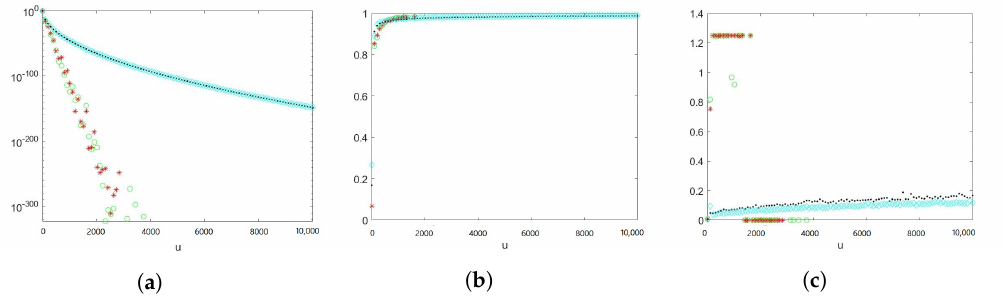
Figure 1. The random variable N is geometrically distributed with success probability p = 0.2, W i i.i.d ∼ Exp ( 1 ) , X i i.i.d ∼ Erlang ( 1,3 ) , where i = 1, . . . , N . Green circles: ConAK1. Red stars: ConAK1+CV. Black dots: ConAK1+IS (conditioning and IS on exponential). Cyan diamonds: ConAK1+IS+CV (conditioning and IS on exponential). ( a ) Estimates of (cid:96) ( u ) as a function of u on a logarithmic scale. ( b ) Empirical logarithmic rates as a function of u . ( c ) Empirical relative errors as a function of u .